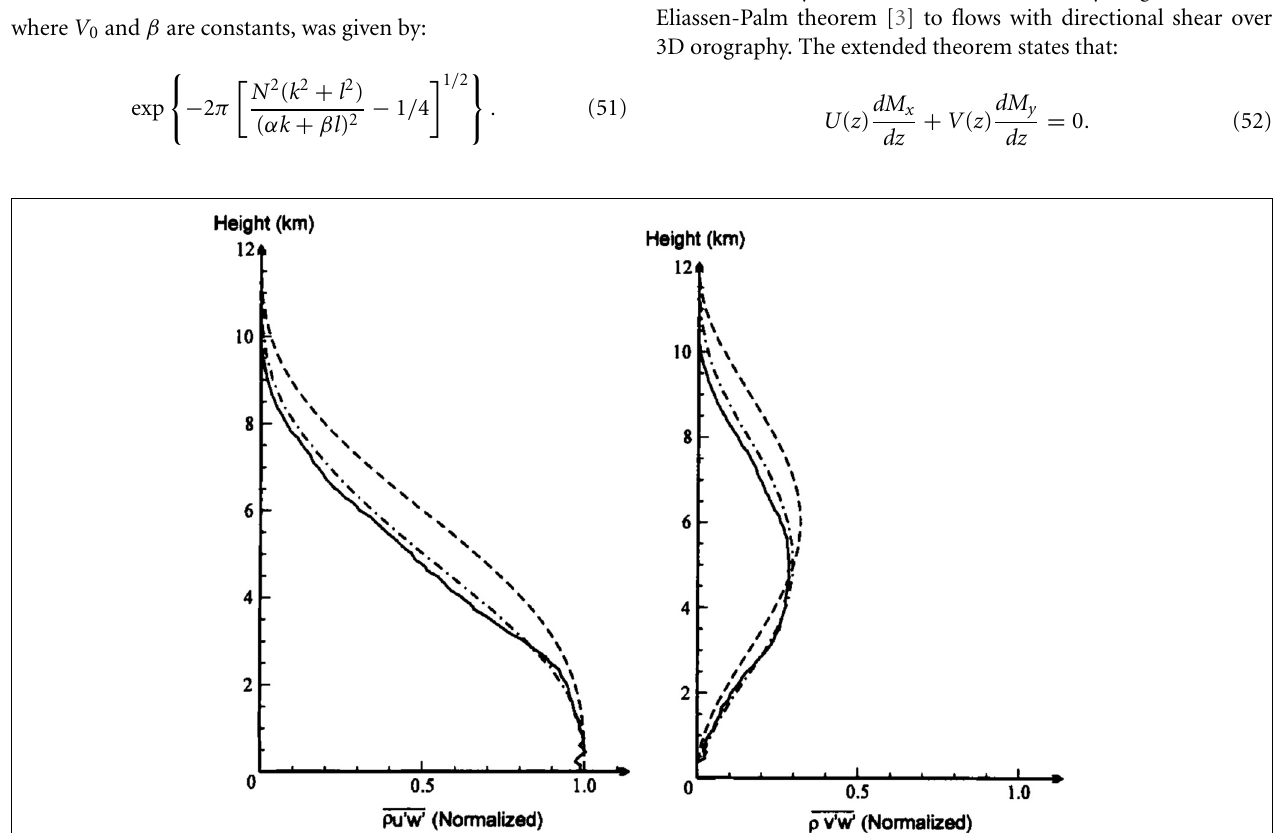
FIGURE 6 | Normalized momentum fluxes as a function of height for the wind profile (41) at very high Ri . Dashed line: infinite-area linear solution, dash- dotted line: linear solution taking into account the finite